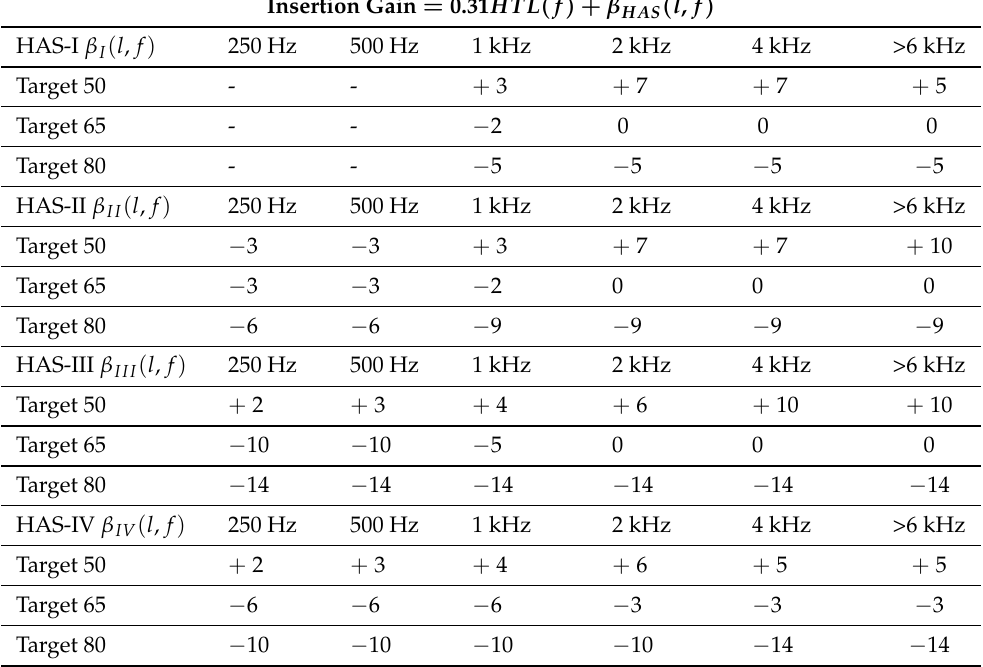
Table 1. Gain prescription for the four candidate hearing-aid settings (HAS). Non-linear gain was calculated for 50, 65, and 80 dB SPL. The gain was calculated based on the hearing thesholds (HTL) and the HAS tested. For each HAS, a correction factor β HAS was applied that reflected different gain prescription approaches (i.e., audibility maximization [10] and loudness normalization [4]). Insertion Gain = 0.31 HTL ( f ) + β HAS ( l , f ) HAS-I β I ( l , f ) 250